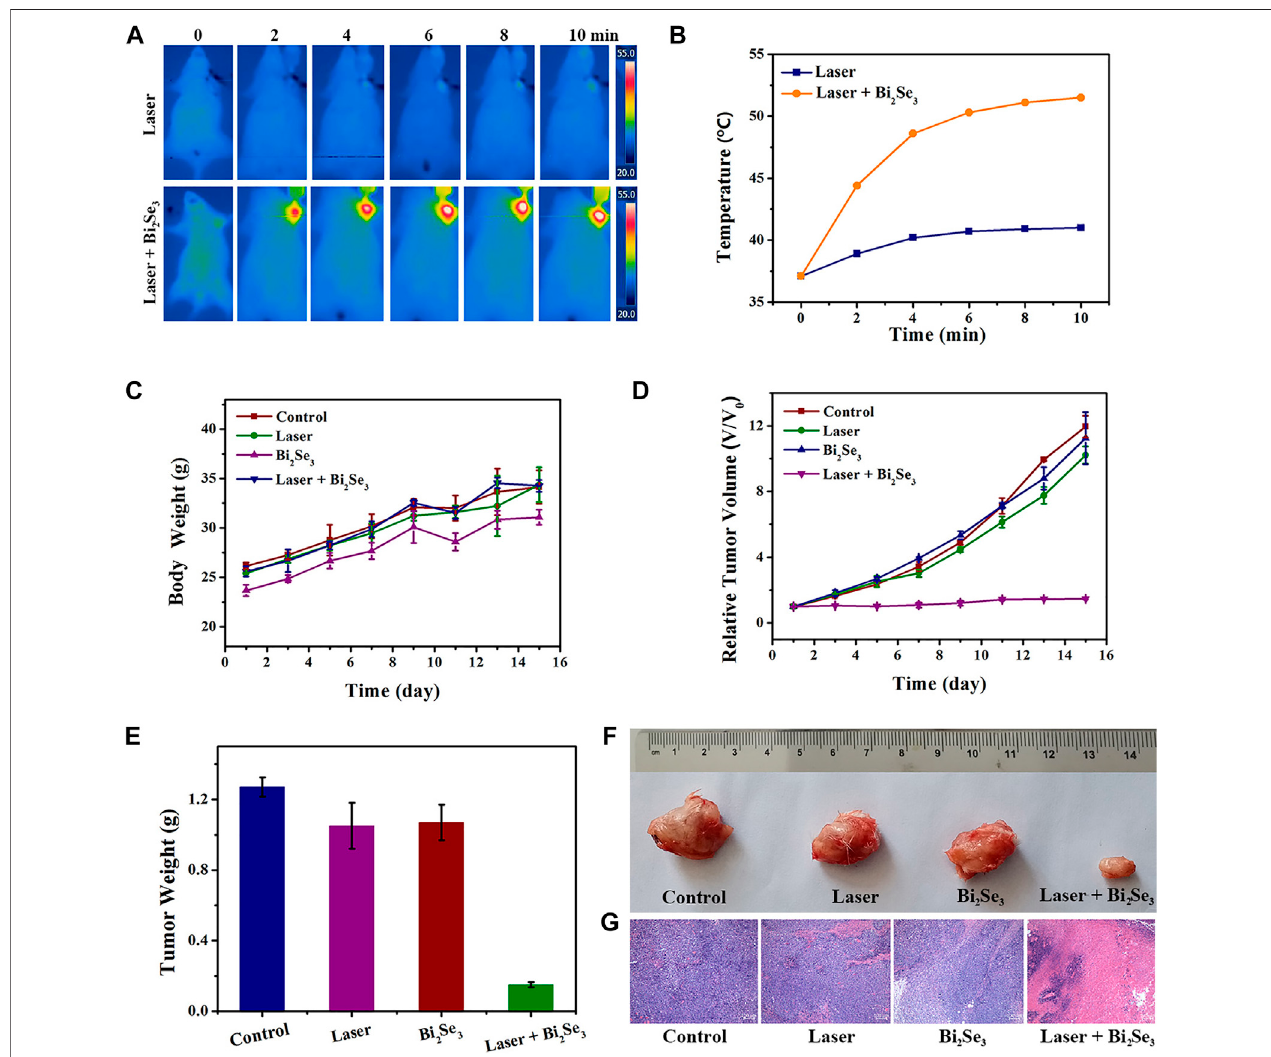
FIGURE 5 | (A) IR thermal images and (B) corresponding curve showing the temperature variation of tumor-bearing mice injected (i.v.) with PBS (control) or PEI- Bi 2 Se 3 nanodots, followed by irradiation witha laserat 808 nm for 10 min (C) Bodyweight ofmice and (D) curves showing relativetumor growth in different groups after various treatments. (E) Mean tumor weight of each group after various treatments. (F) Photographs of tumors of each group and (G) H&E staining of tumor slides collected from different groups. All scale bars (cid:1) 100